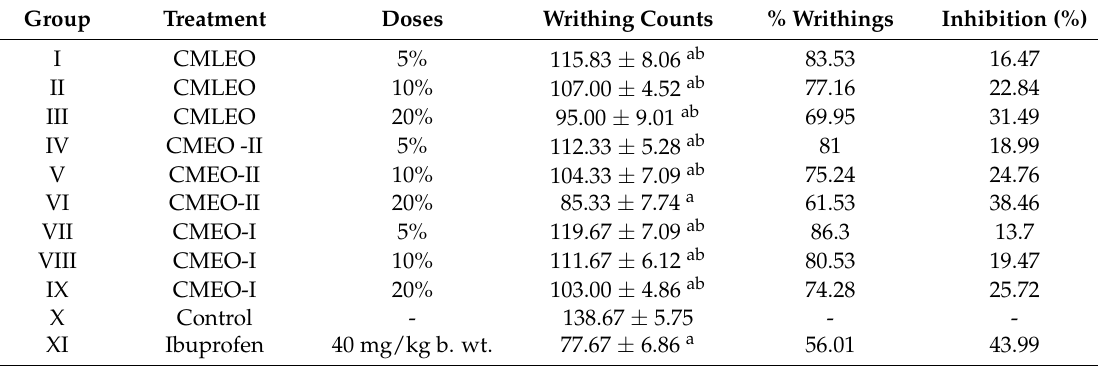
Table 5. Effect of essential oils from C. macophylla on acetic acid induced writhing in